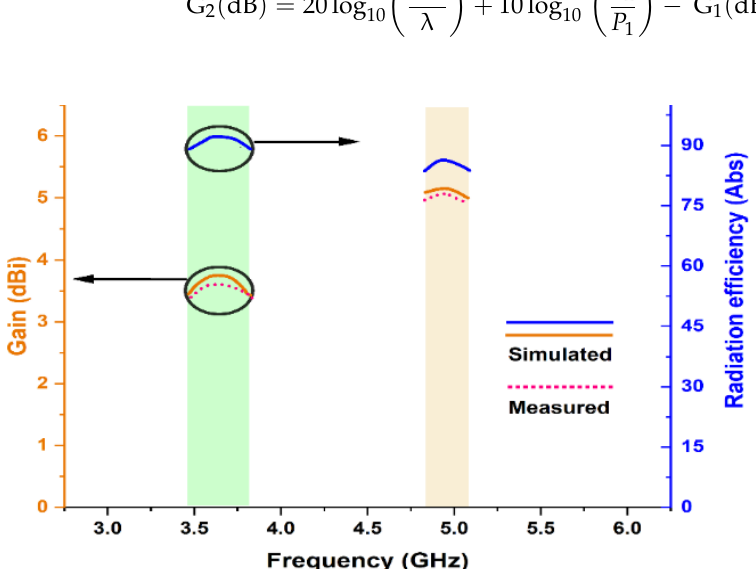
Figure 13. Graph of gain and radiation efficiency vs. frequency.